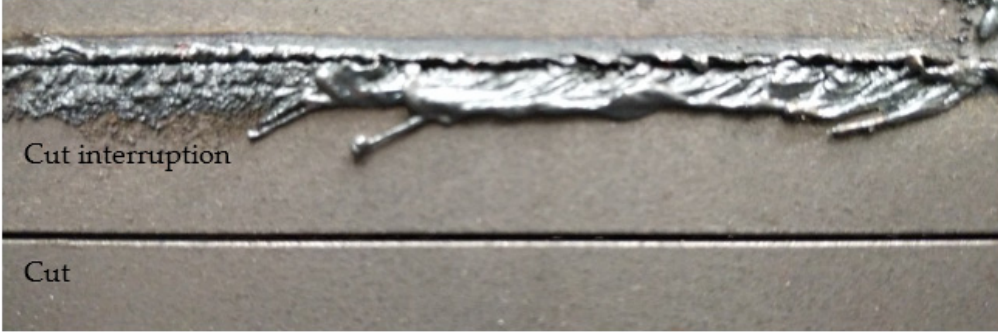
Figure 2. Top view of a metal sheet with a cut interruption ( top ) and complete cut ( bottom ).